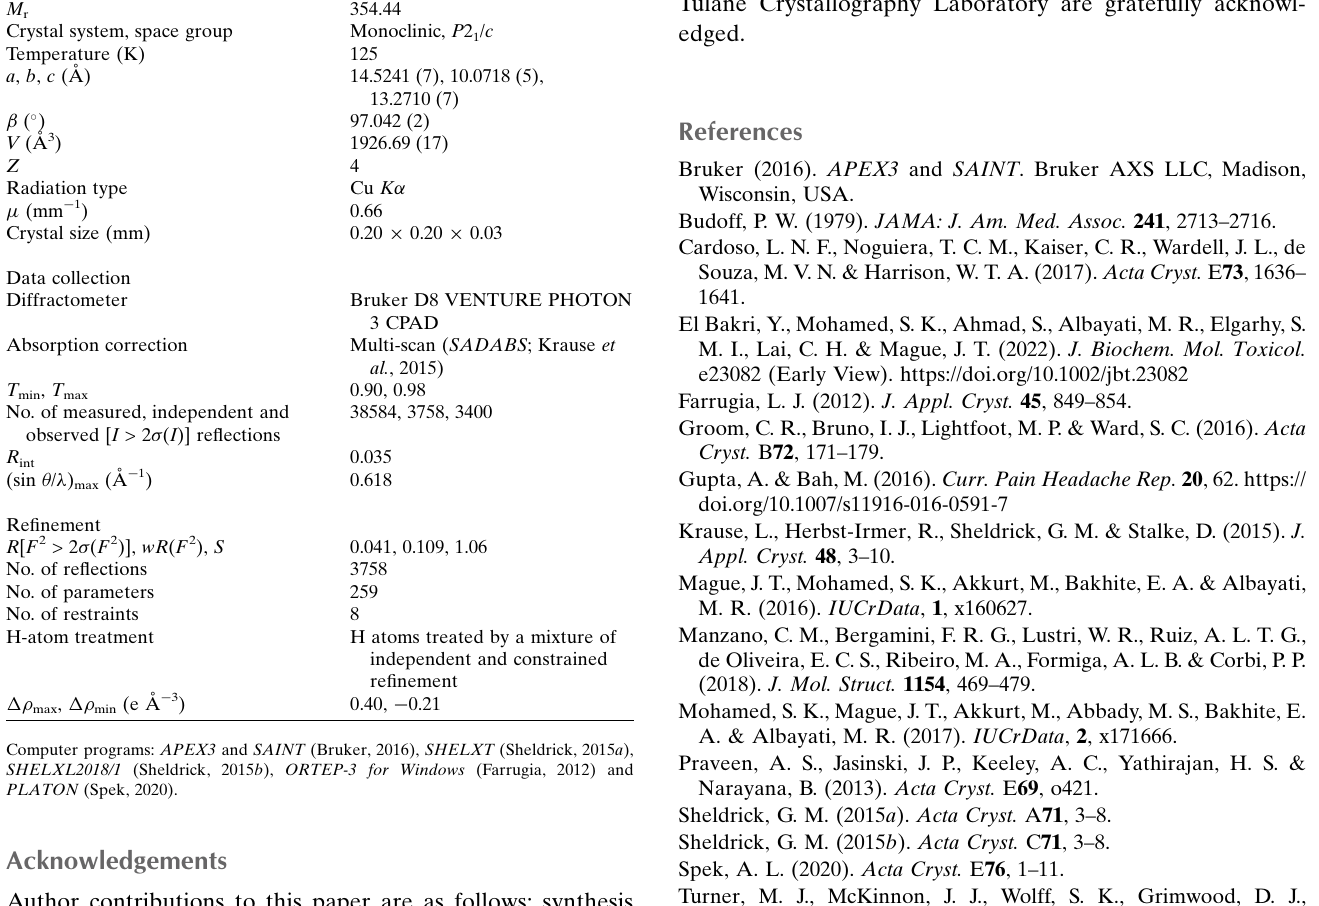
Crystal data Chemical